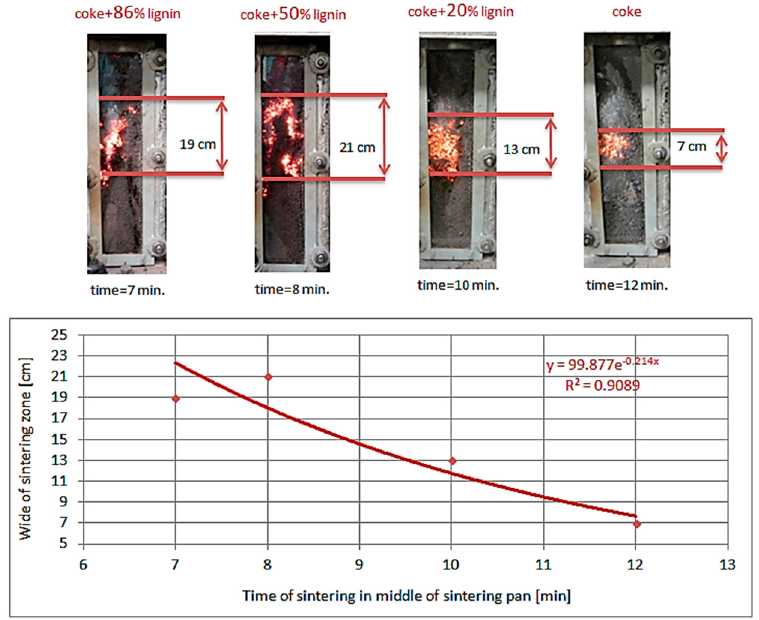
Figure 3. Characteristics of the sintering zone in the production of agglomerates using coke and lignin.